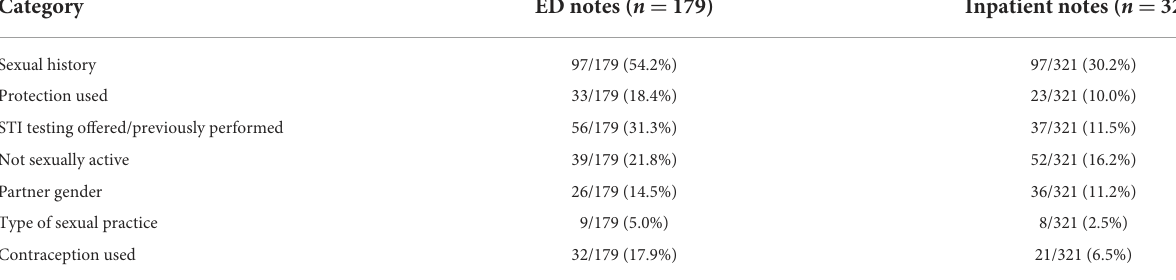
TABLE 2 Frequency of sexual history and the 5P’s in notes based on manual